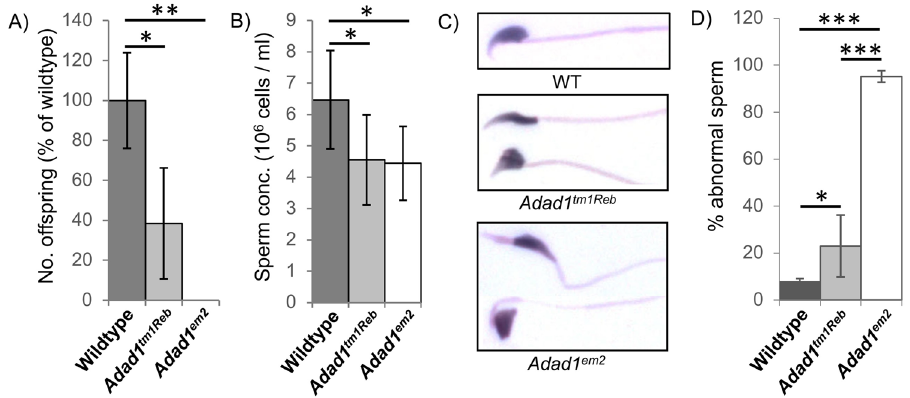
Figure 3. Comparative phenotypes in Adad1 tm1Reb and Adad1 em2 males. Quantification of wildtype and homozygous Adad1 mutant ( A ) offspring sired (N = 3) and ( B ) epididymal sperm concentration (N ≥ 4). ( C ) Representative comparison of mature spermatozoa morphology between wildtype, Adad1 tm1Reb , and Adad1 em2 males. ( D ) Quantification of morphologically abnormal epididymal sperm in homozygous mutant Adad1 tm1Reb and Adad1 em2 adult males. Error bars—standard deviation, * p-value < 0.05, ** p-value < 0.005, *** p-value <